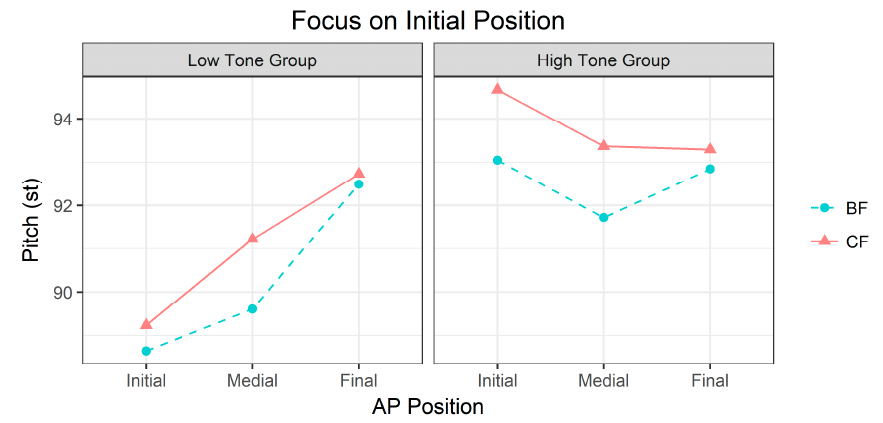
Figure 7. AP (Accentual Phrase) tonal patterns with three digits in two focus conditions (broad vs. corrective), separated by tone group. BF is shown here for reference only.